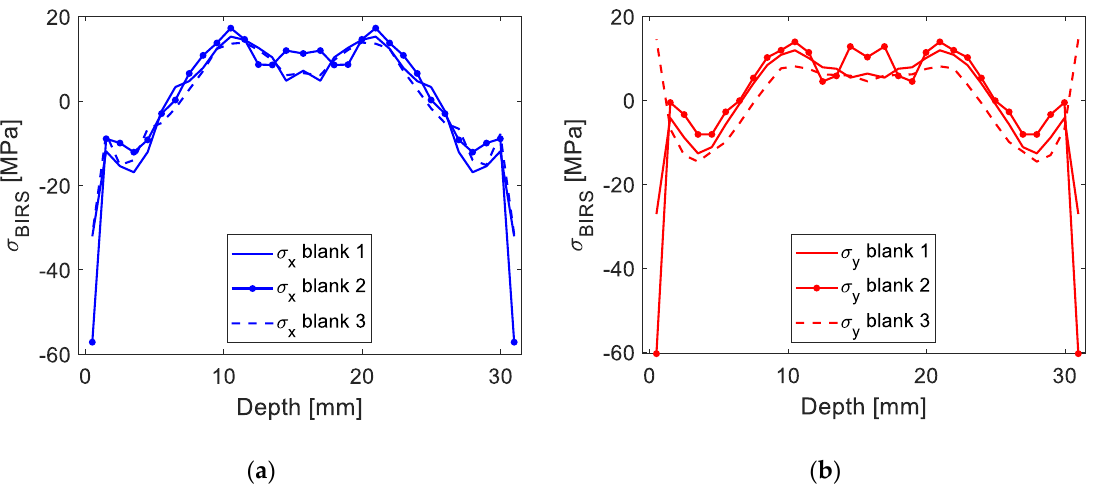
Figure 11. Measured BIRS profile in three Al7050-T7451 machining blanks considering only BIRS: In X direction ( a ), and in Y direction ( b ).